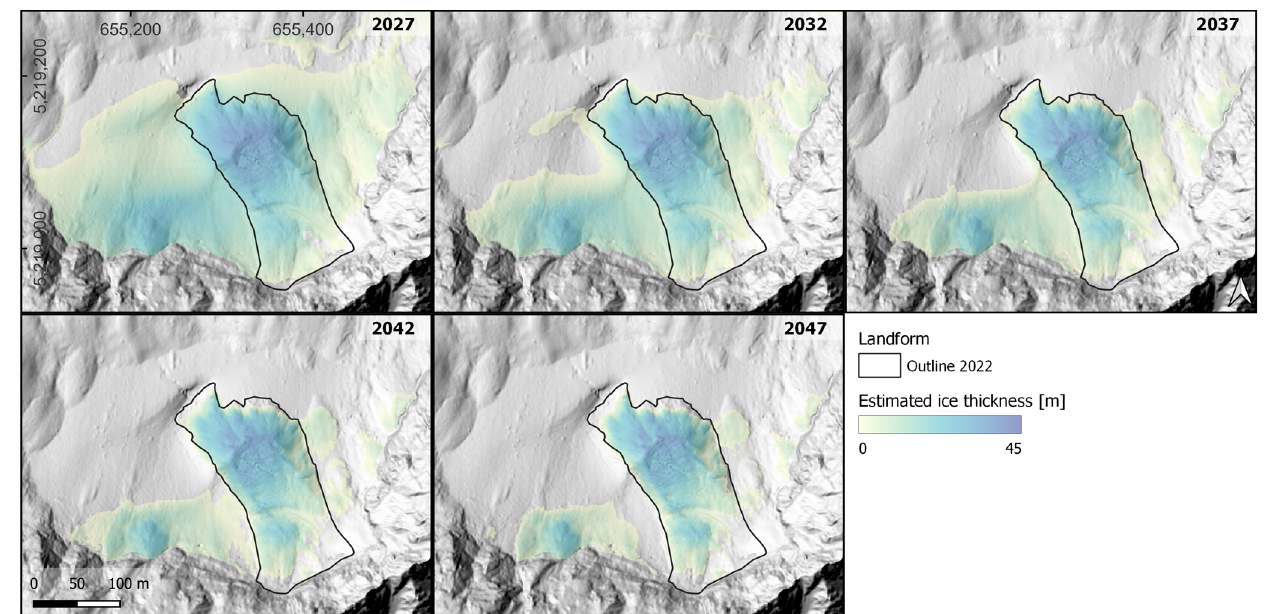
Figure 6. Estimated future development of ice thickness and glacier extent in five-year steps assuming constant surface elevation changes regarding the period 2017–2022. The base map for all years is the hillshade of the DEM from 2022. Additional processes, including the redistribution of debris, the development of surface morphology, and flow movement, along with debris and avalanche input from the headwall, will alter the extent and appearance of the landform compared to its current state in 2022. It should be noted that these changes are not accounted for in this figure.